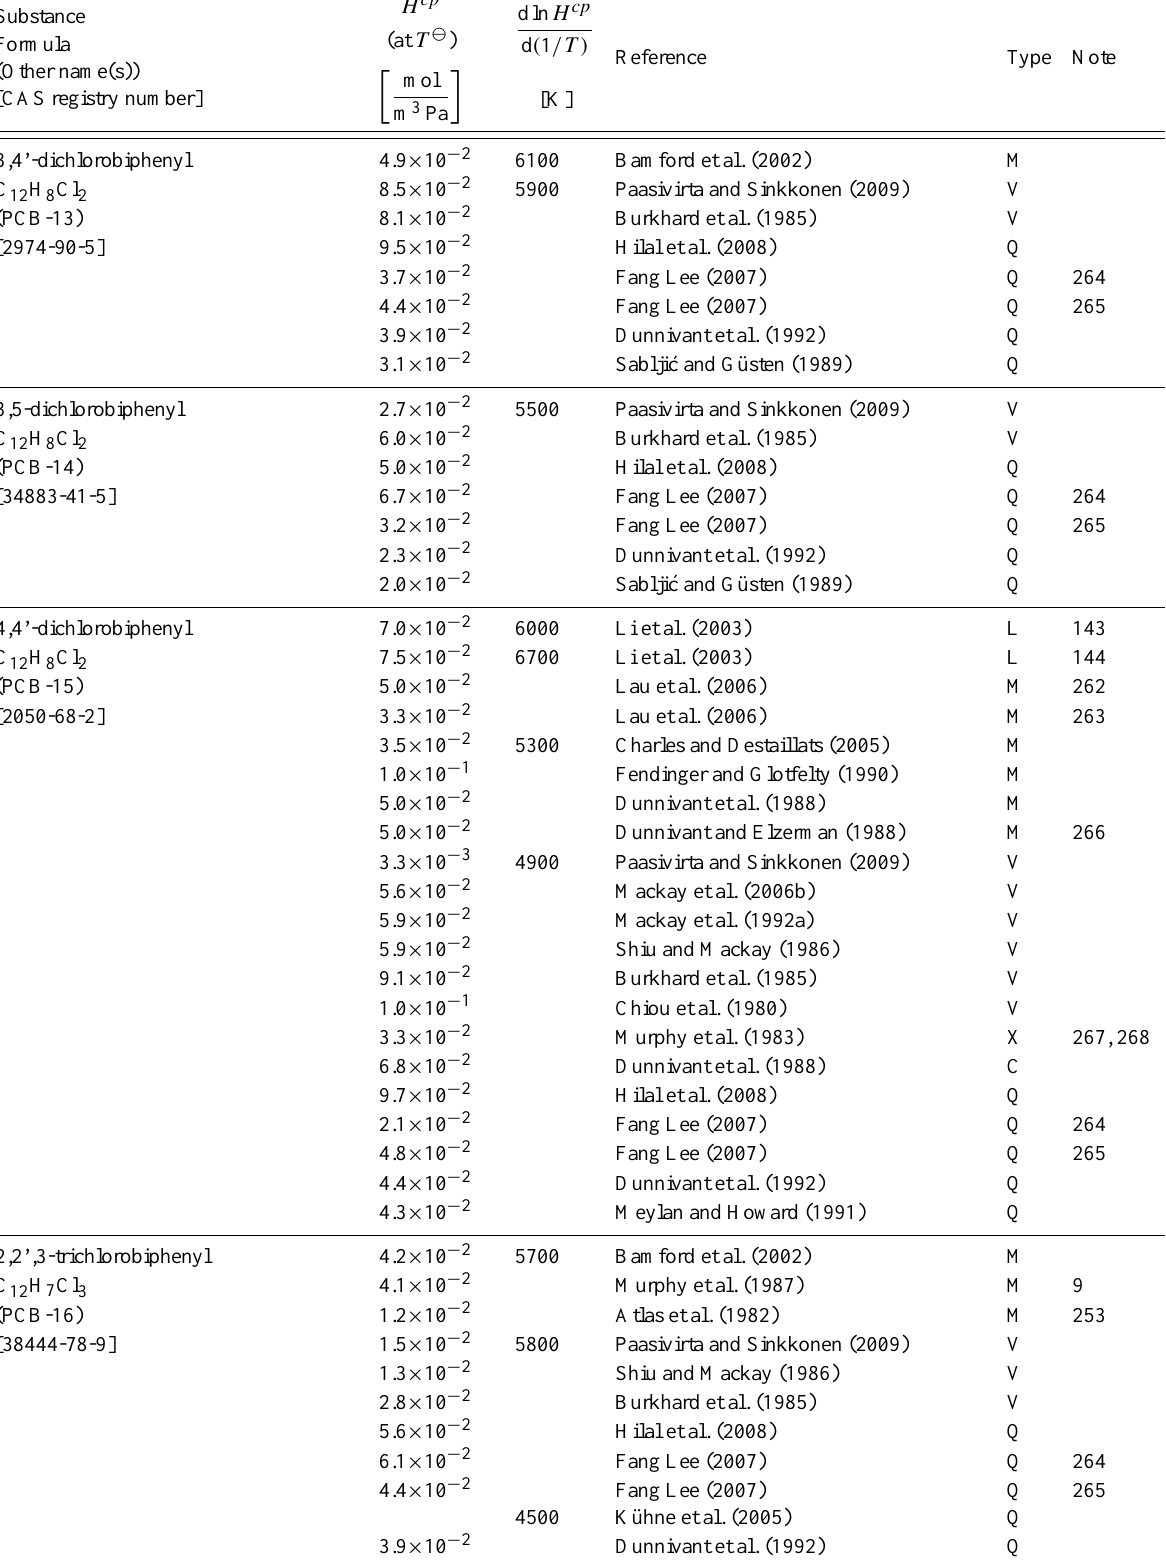
Table 6: Henry’s law constants for water as solvent